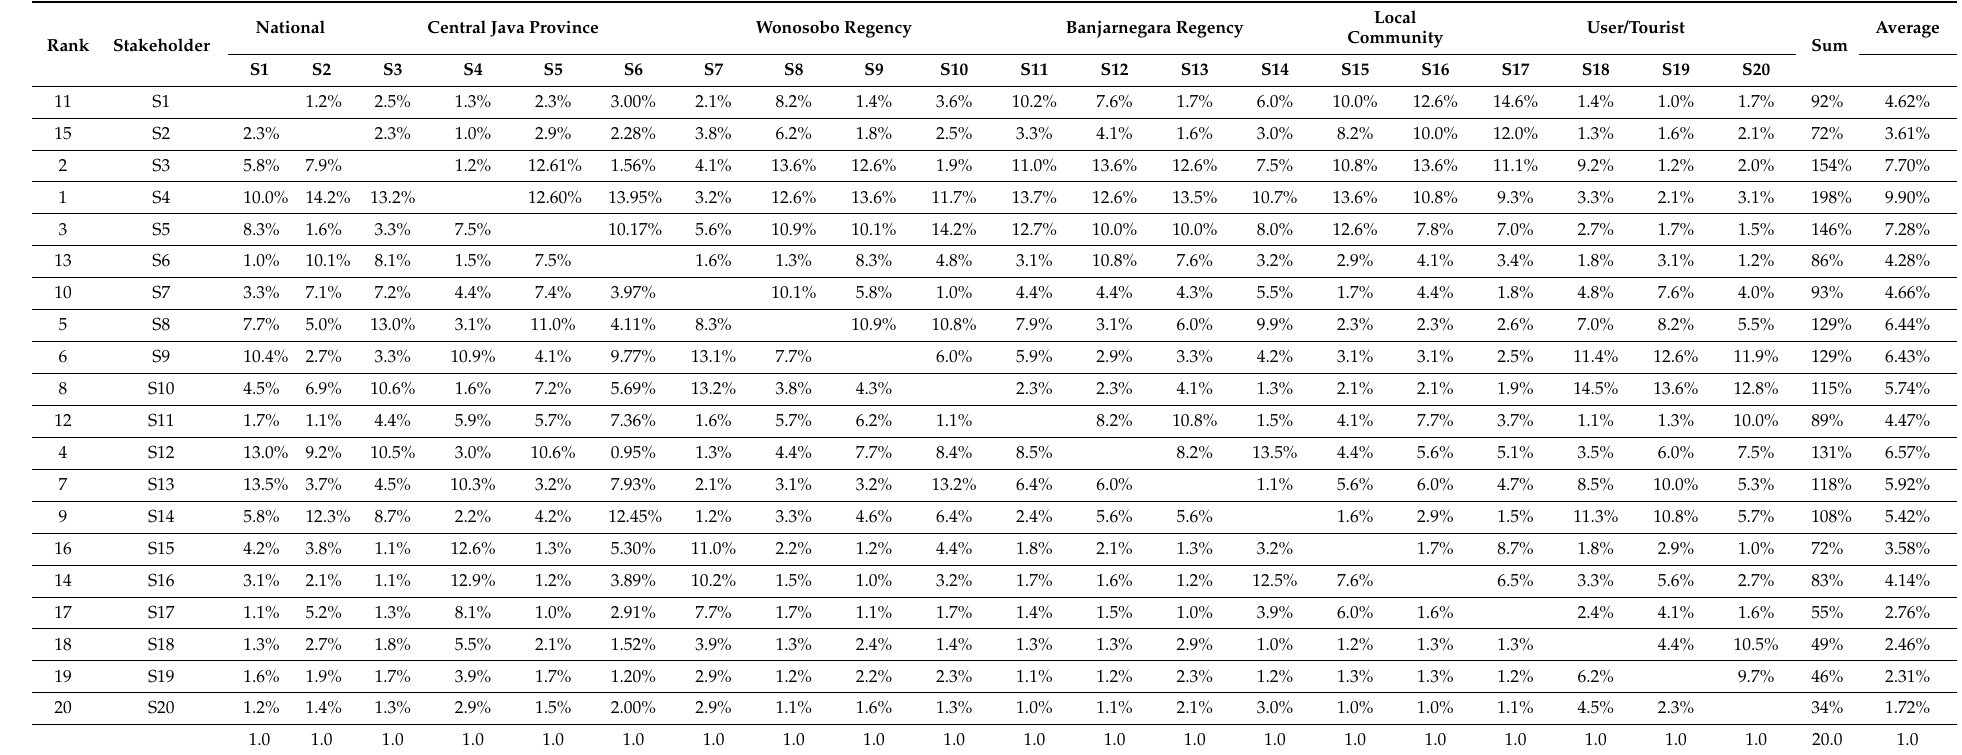
Table 4. Stakeholder